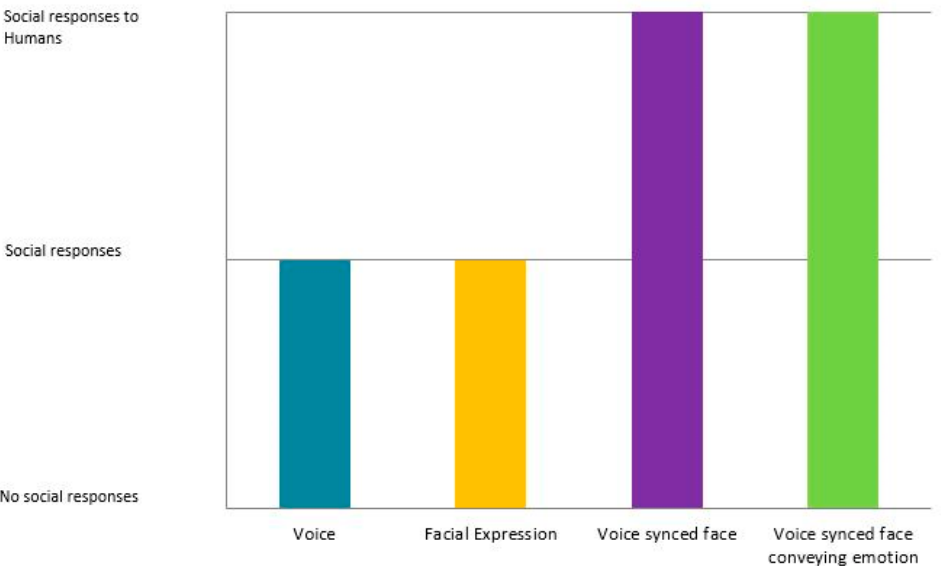
Figure 7. Social responses as a function of human-like characteristics.